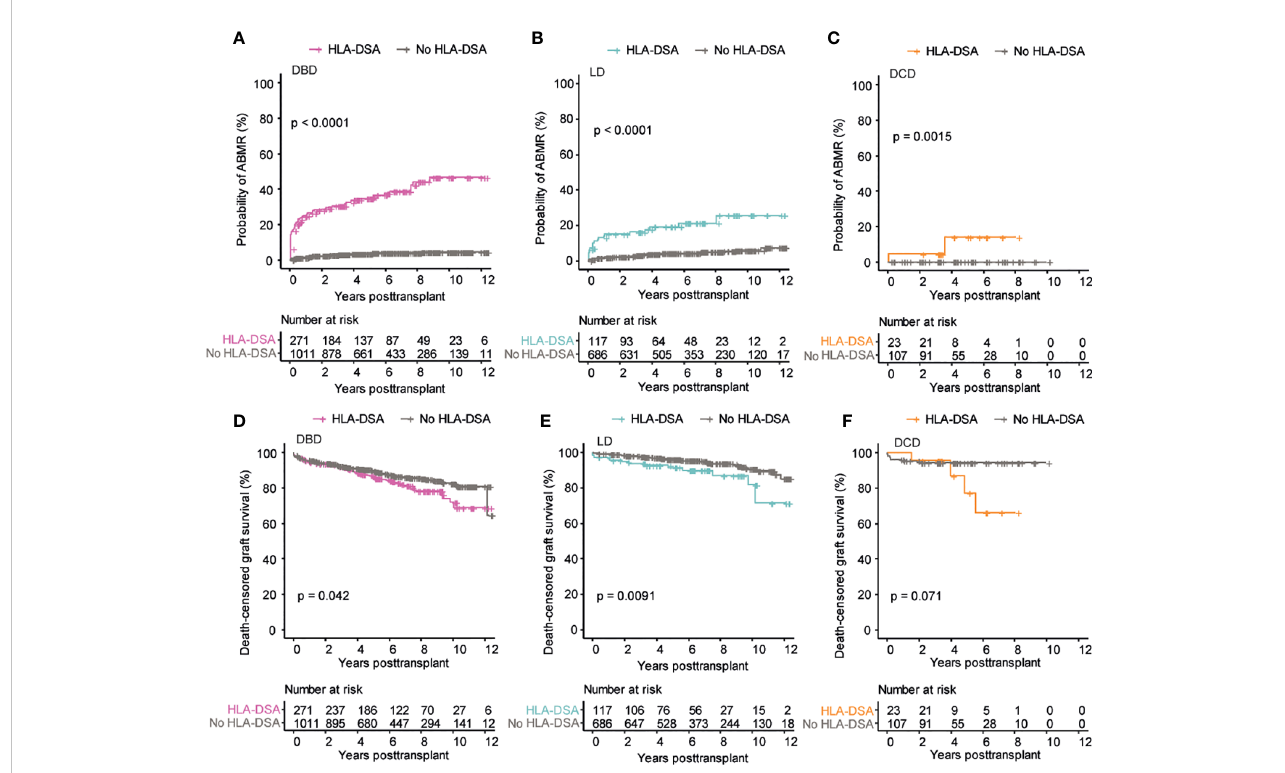
FIGURE 3 Pre-transplant DSA signi fi cantly impacts transplantation outcome in all the three donation types. Cumulative incidence of ABMR in patients who received DBD transplants (A) , LD transplants (B) , and DCD transplants (C) . Cumulative incidence of death-censored graft survival in patients who received DBD transplants (D) , LD transplants (E) , and DCD transplants (F) . Log-rank test was used to test p value of the Kaplan-Meier survival curves for all the